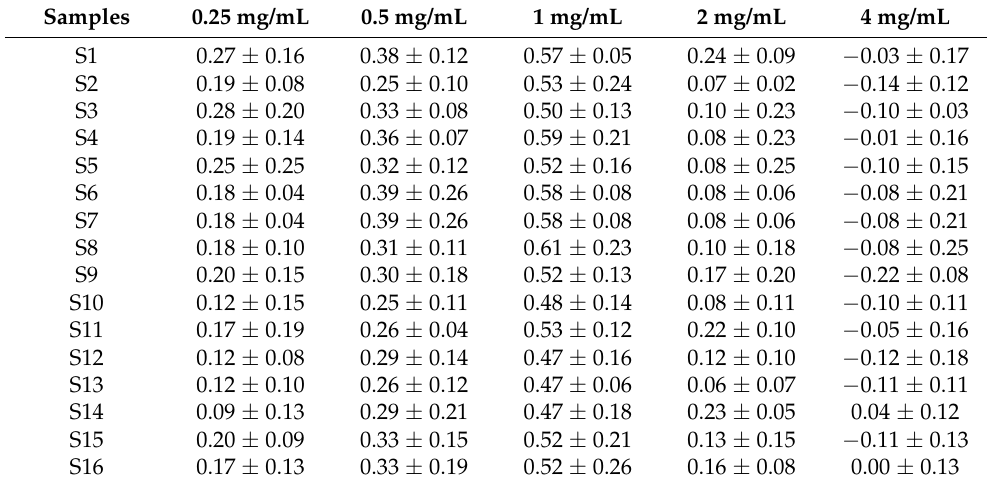
Table 4. The inhibition rates of 16 batches of WDD (Mean ± SD, n = 3,).